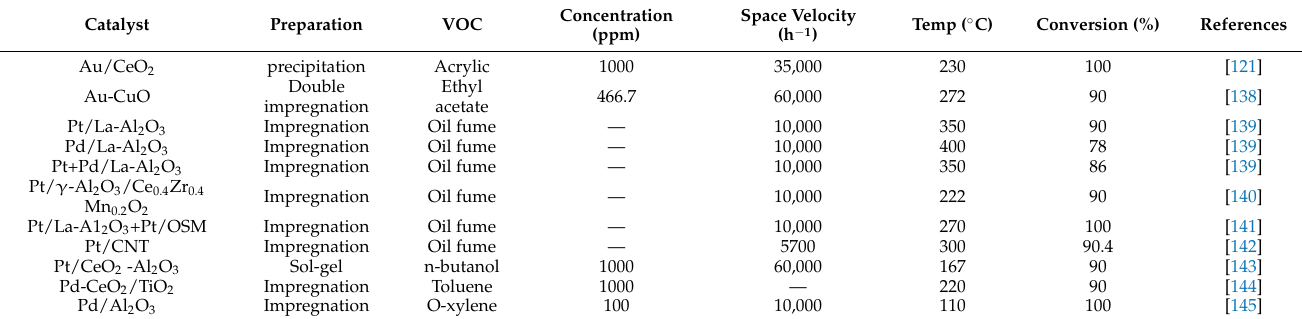
Table 5. Noble metal catalysts for catalytic oxidation of